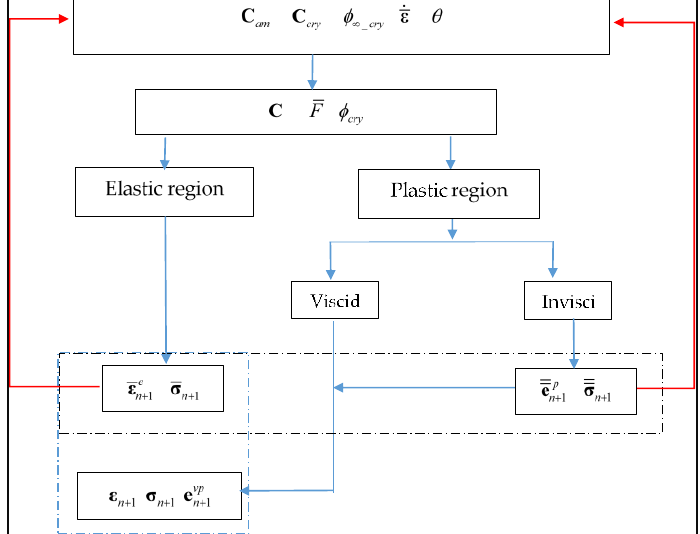
Figure 1. Algorithm of the model implementation.